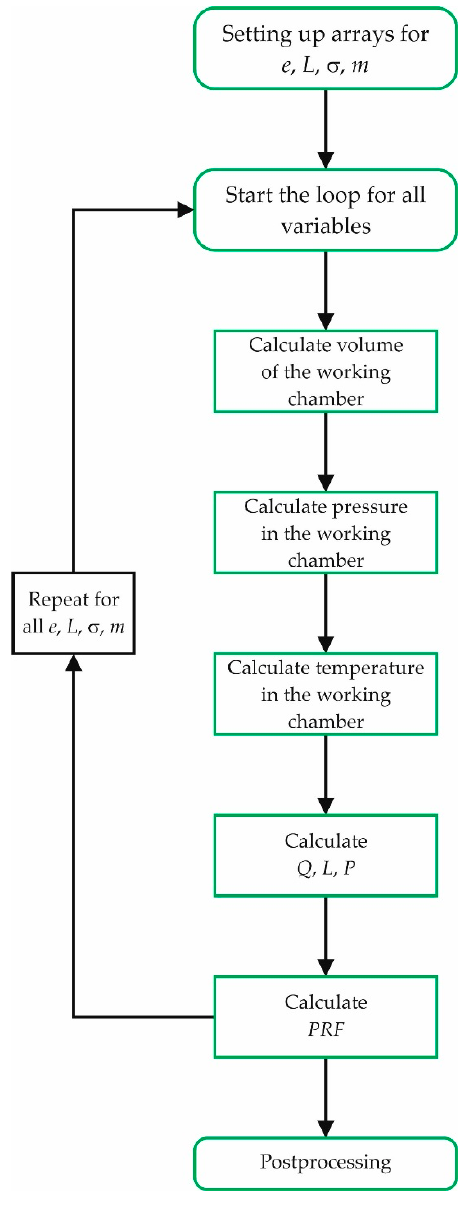
Figure 6. Flowchart of the computational procedure.